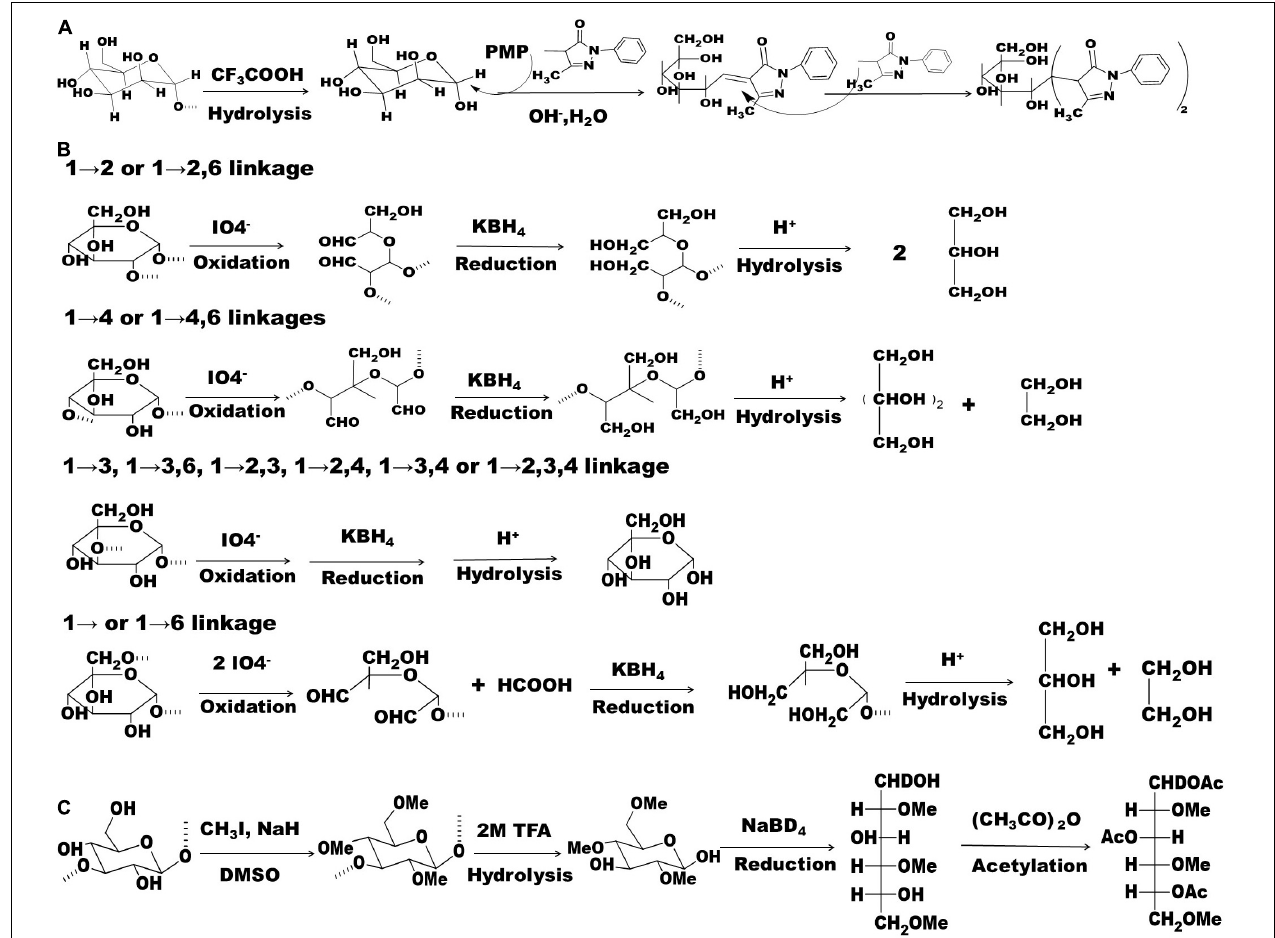
FIGURE 1 | Chemical reactions related to PMP derivatization, periodate oxidation-smith degradation, and methylation. (A) Polysaccharide hydrolysis and monosaccharide derivatization with PMP; (B) chemical reactions of periodate oxidation-Smith degradation; (C) chemical reactions that involved in polysaccharide methylation. PMP: